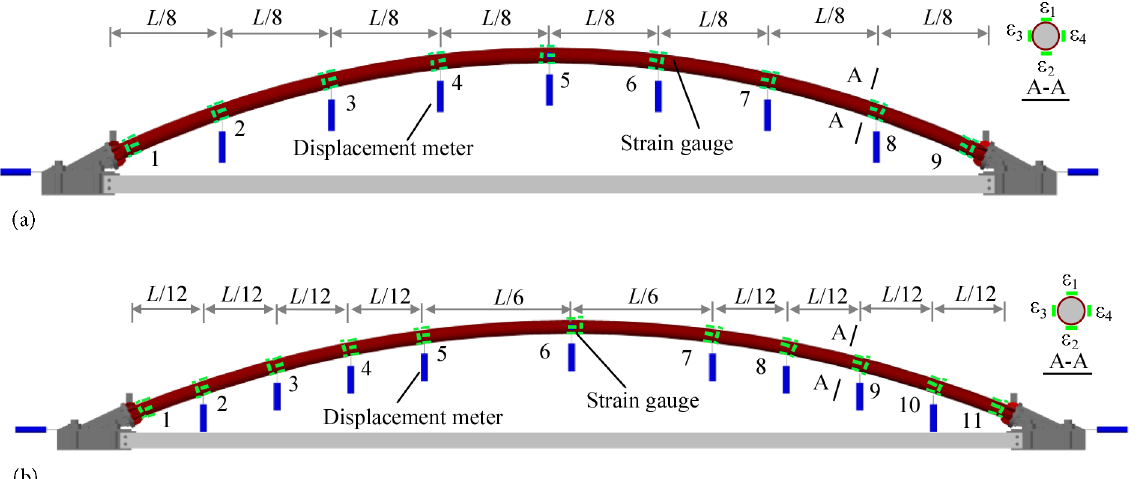
Figure 2. The measuring scheme of experimental arches under: a – loading case 1 or loading case 2; b – loading case